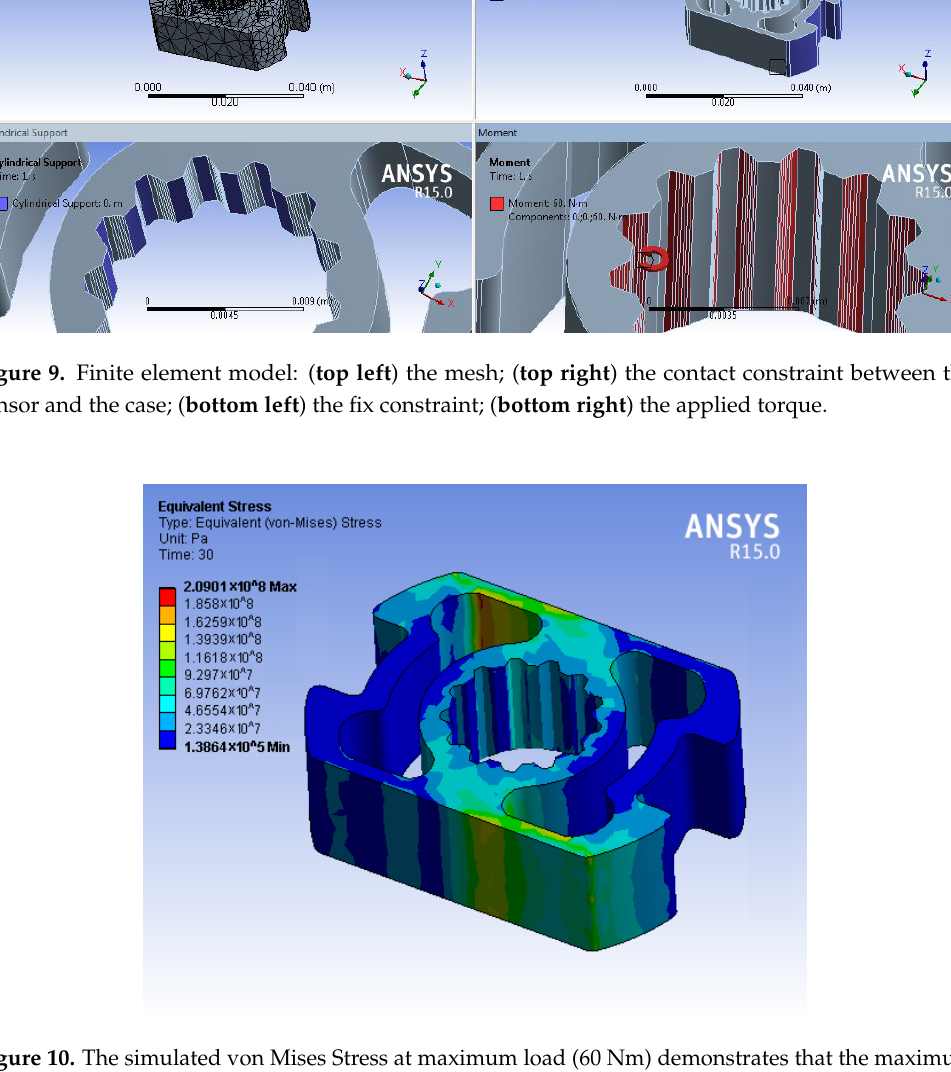
Figure 10. The simulated von Mises Stress at maximum load (60 Nm) demonstrates that the maximum stress value of the torque sensor is about 25% of the yield point of the steel alloy